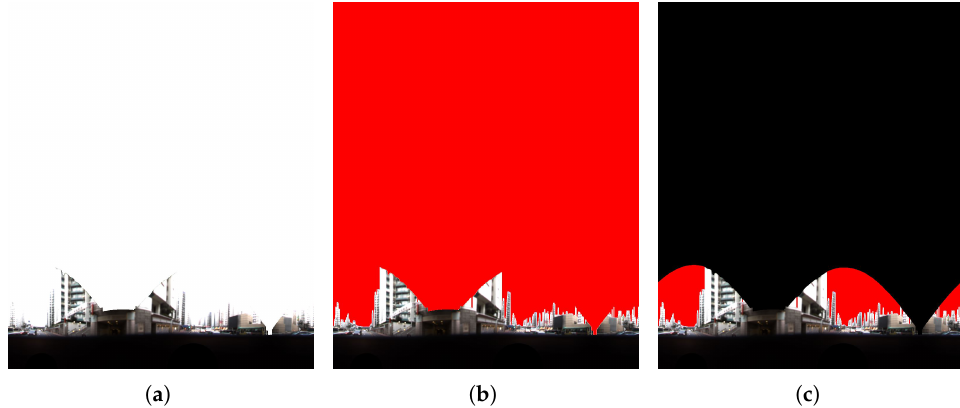
Figure 8. Results of the improved sky region detection algorithm in a practical test of the case of a flyover blocking the field of view of the omnidirectional camera. ( a ) Temporarily treating the flyover region as part of the sky region. ( b ) Sky region detection. ( c ) Restoration of the flyover